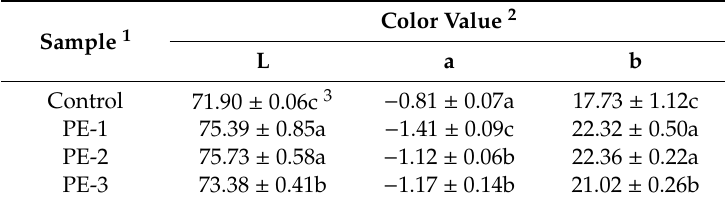
Table 2. Hunter’s color values of soybean sprouts grown after seed-soaking in di ff erent concentrations of Pu-erh tea